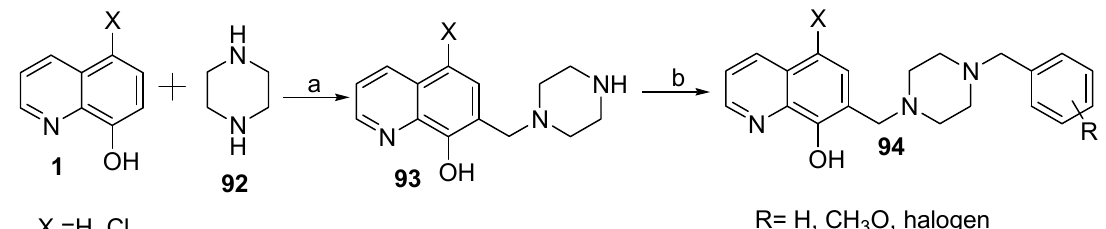
Figure 6. Chemical structures of some indole-based 8-hydroxyquinoline derivatives. Reagents: ( a ) acetic anhydride, 2-nitrobenzaldehydes; ( b ) 1,10-phenathroline·H 2 O, Pd(OAc) 2 , CO; ( c ) K 2 CO 3 or NaOCH